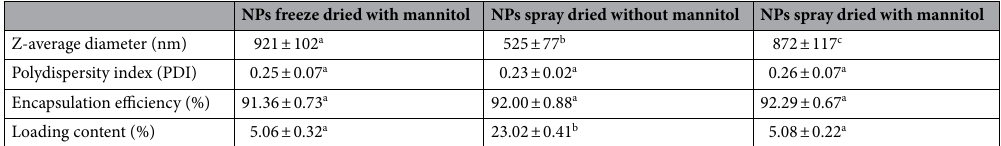
Table 2. Physicochemical properties of NPs after three-month storage (one way ANOVA comparisons, p < 0.05).